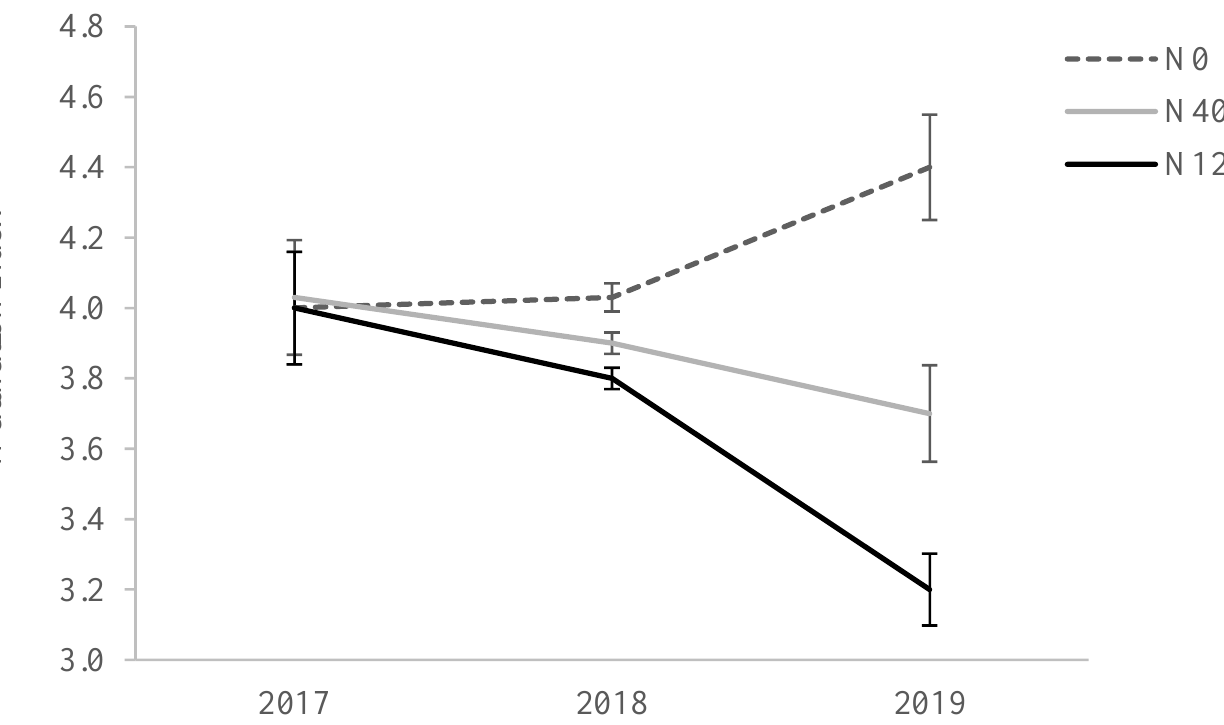
Figure 2. Maturation index of olives from trees supplied with 0 (N0), 40 (N40) and 120 (N120) kg ha − 1 of N in the harvests of 2017, 2018 and 2019.